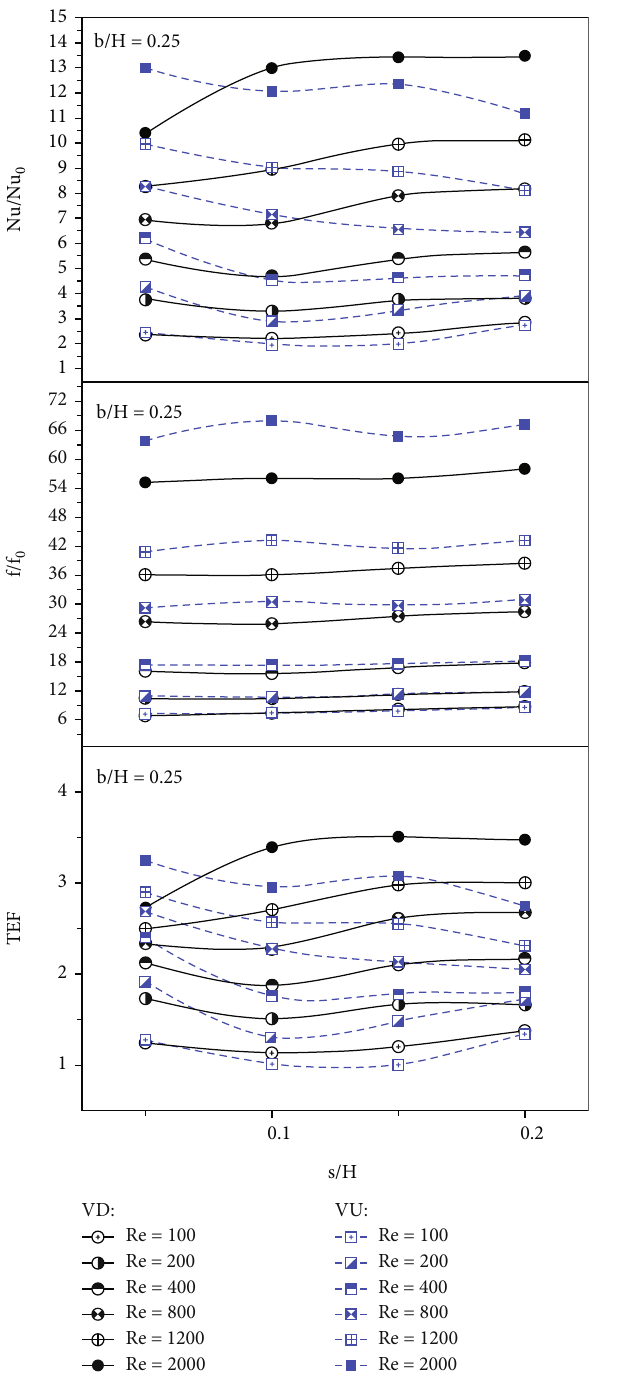
Figure 13: Thermal performance analysis of b/H =0.25. Figure 14: Thermal performance analysis of b / H = 0 : 30